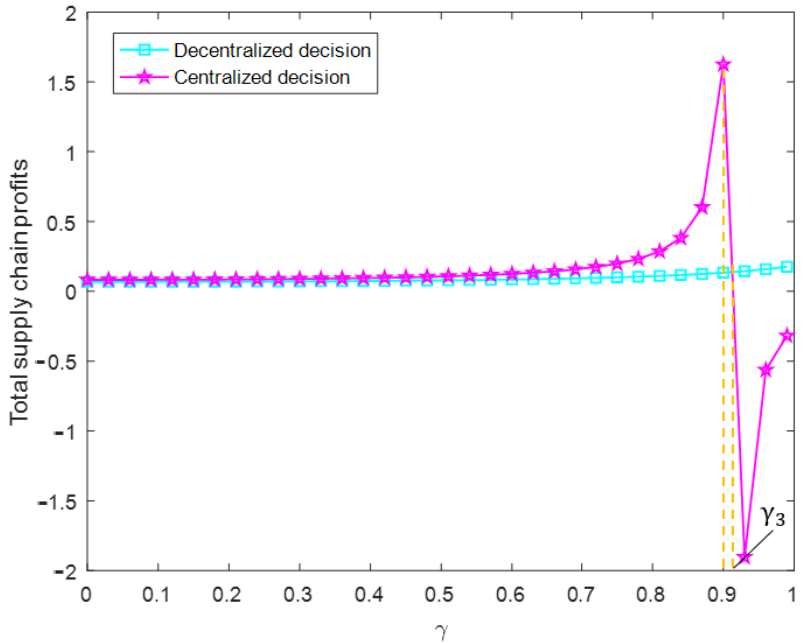
Figure 4. The impact of 𝛾 on total CDW supply chain profit without government subsidies.